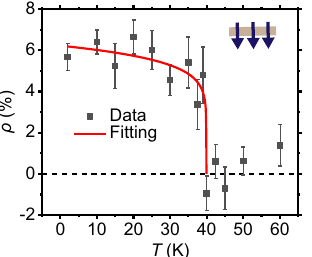
Fig. 3 Temperature-dependent photoresponsivity polarization of the light helicity detector D1 measured at zero magnetic fi eld. As temperature decreases from 80 to 2K, ρ (black dots) increases from 0% (the dashed line) to a saturated value of 6%, corresponding to the down magnetized state of CrI 3 . The helicities ρ , together with the error bars, are obtained by fi tting the relation between the photocurrent and the angle of the quarter-wave plate. By fi tting the data with ρ T ð Þ ¼ ρ ð 1 (cid:2) T Þ β (red line), we obtain T = 40K. c T c 0